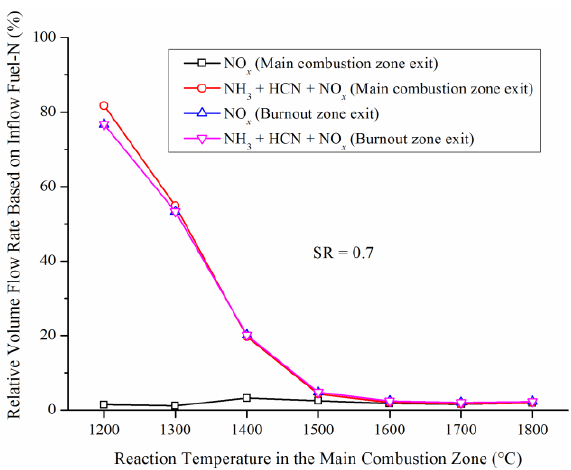
Figure 5. Sums of NH 3 , HCN and NO x at the exits in staged air combustion (reaction temperature in the burnout zone: 1100 °C).